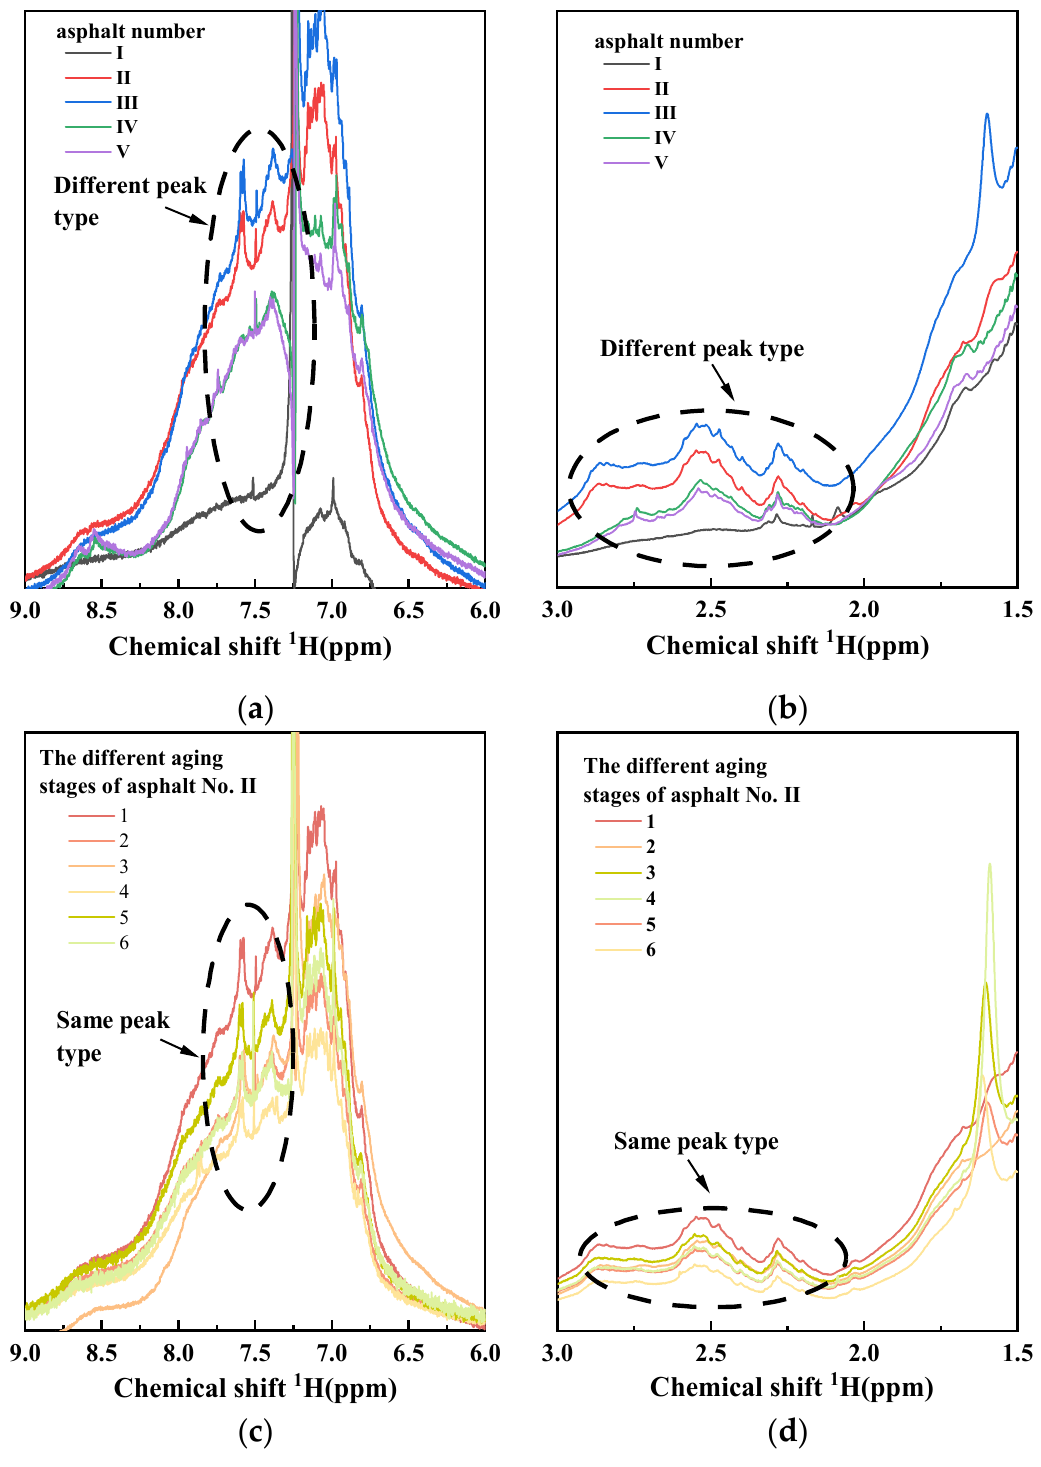
Figure 4. Local magnification of 1 H-NMR. ( a ) Partial magnification of the aromatic region of the five unaged asphalts; ( b ) partial magnification of the aliphatic region of the five unaged asphalts; ( c ) partial magnification of the aromatic region of the different aging stages of asphalt No. Ⅱ ; ( d ) partial magnification of the aliphatic region of the different aging stages of asphalt No. Ⅱ .